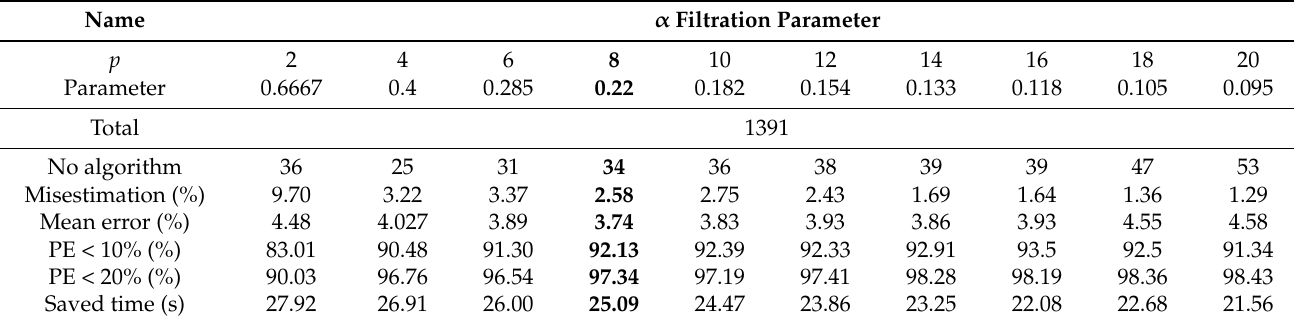
Table 1. Summary of α parameter.